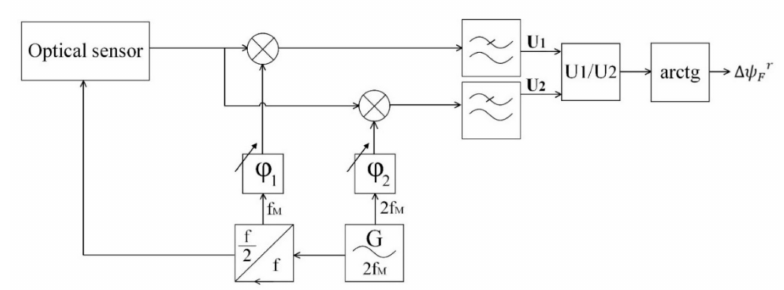
Figure 2. Block diagram of the signal demodulation